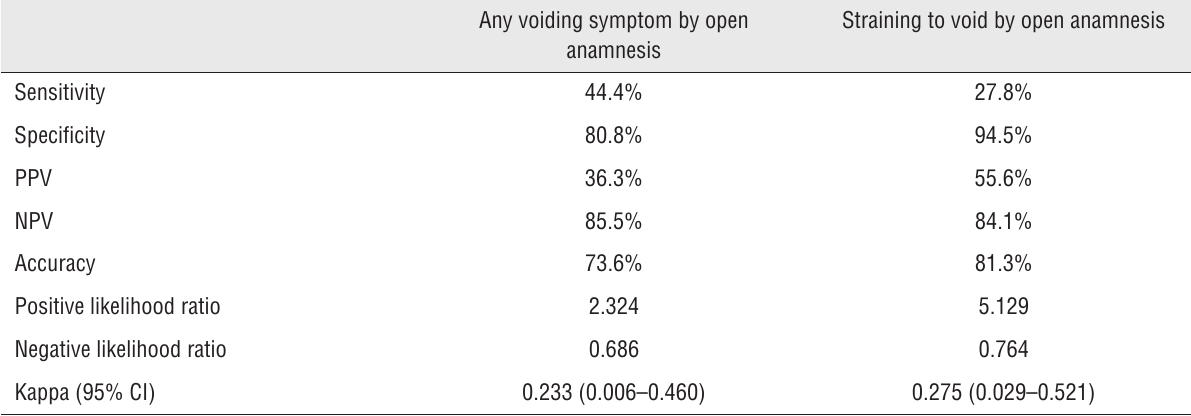
Table 4 - Voiding symptoms as predictors of voiding dysfunction in women with previous anti-incontinence surgery. Any voiding symptom by